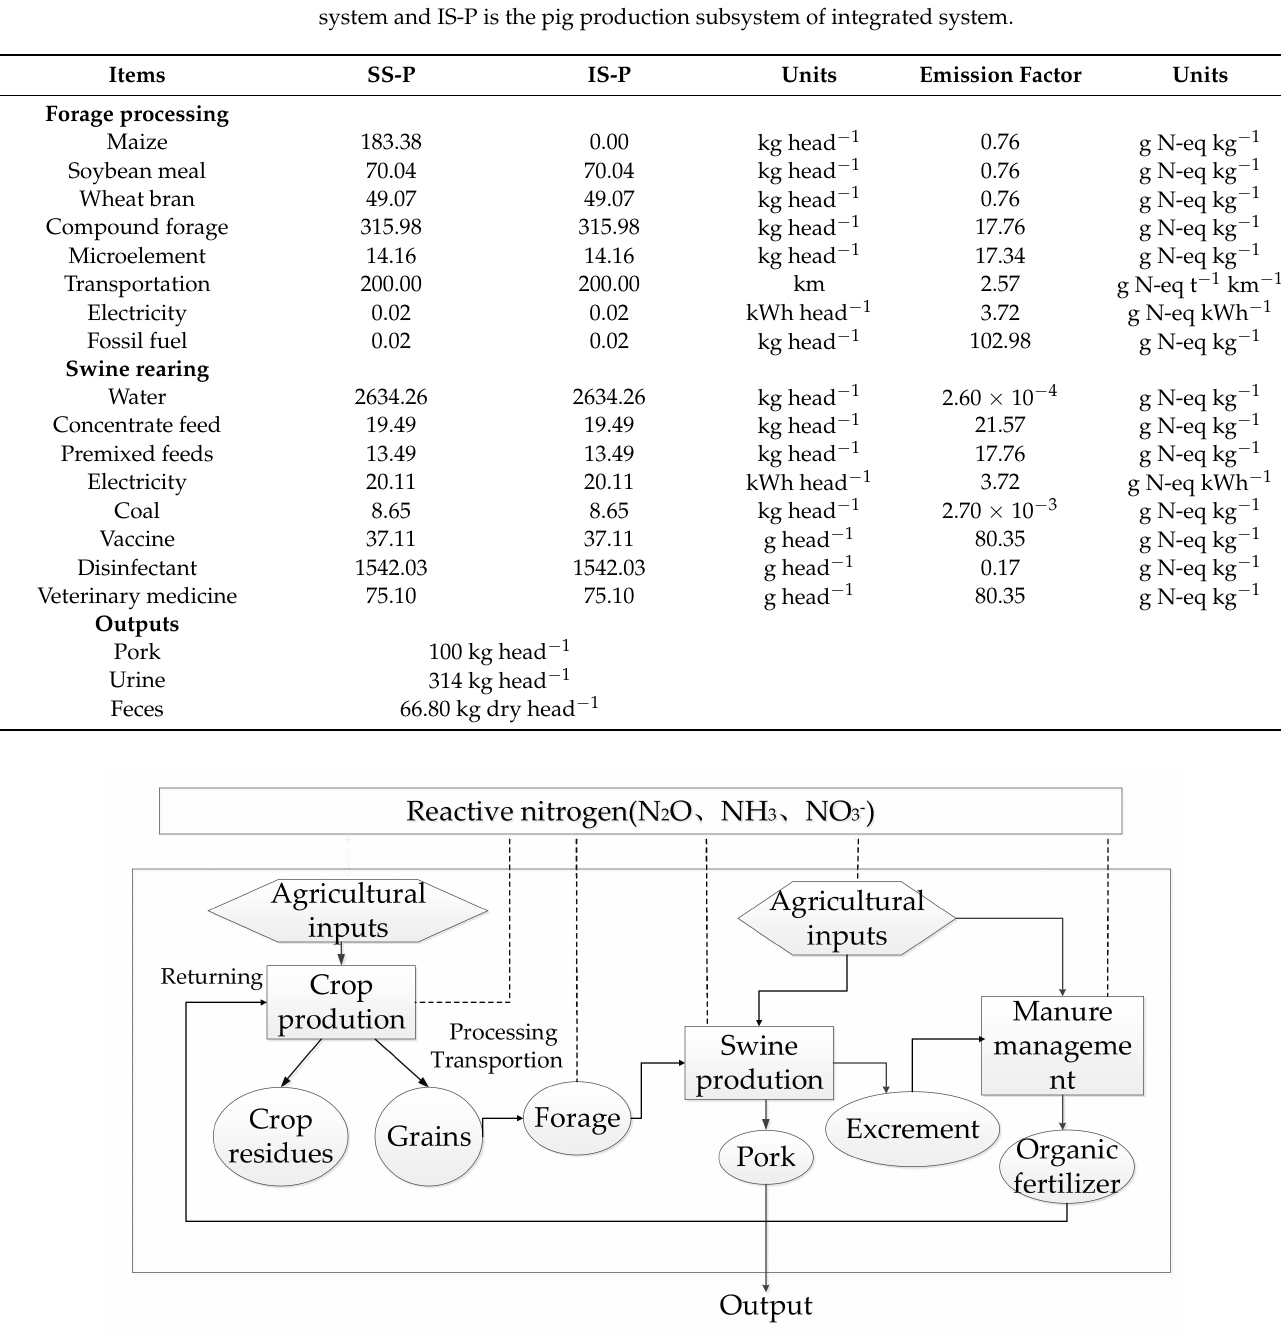
Figure 2. System boundary of the Crop-swine integrated system (IS). Notes: solid arrow denotes energy and material flows under agriculture practices, dotted arrow denotes reactive nitrogen emissions from